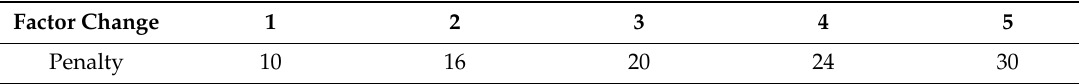
Table 2. Penalty of hardness jump.